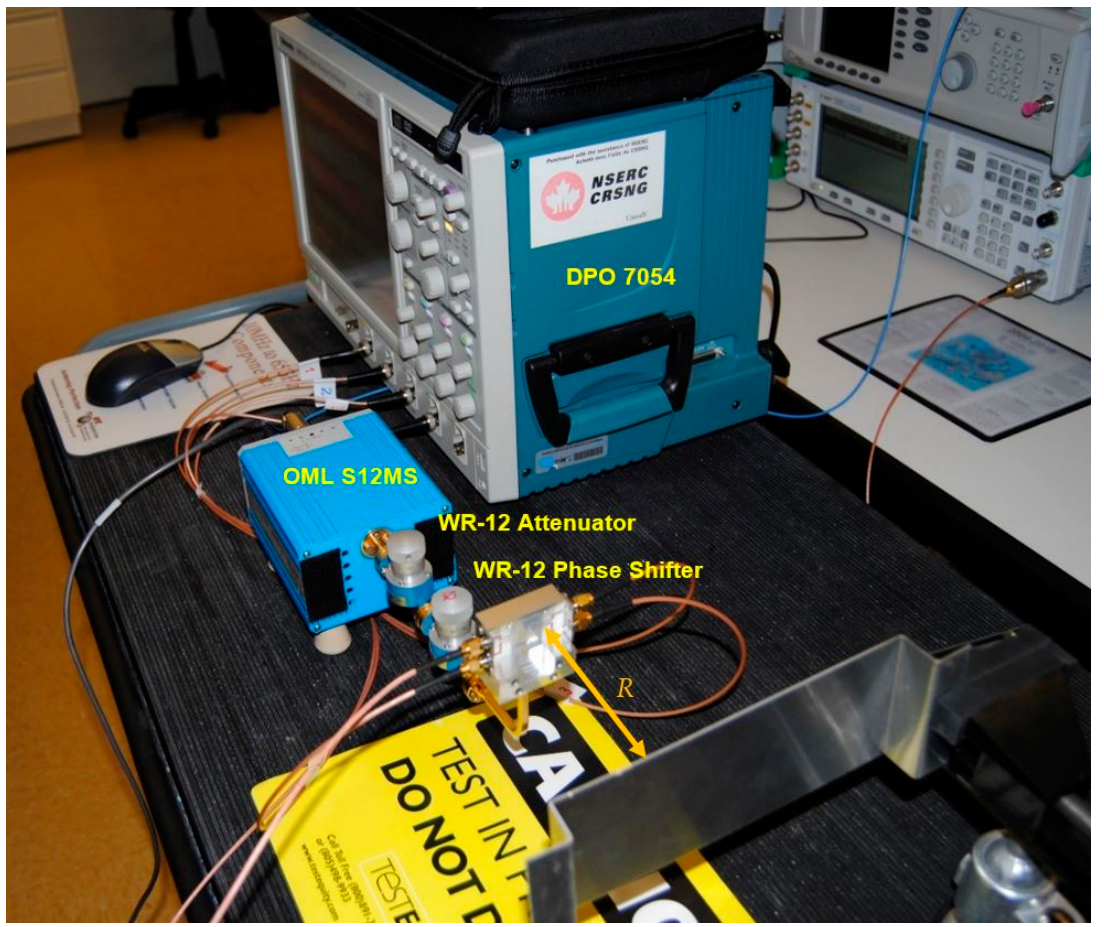
Figure 48. E-band radar in test with a metallic target.